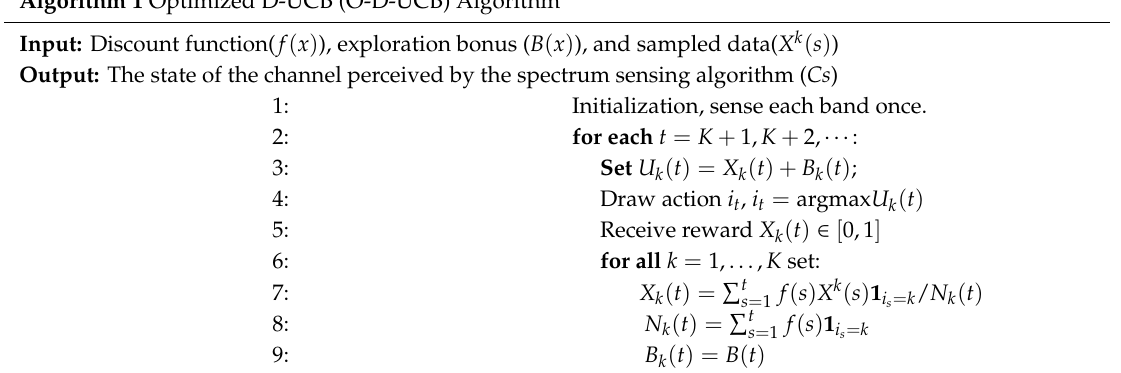
Algorithm 1 Optimized D-UCB (O-D-UCB)